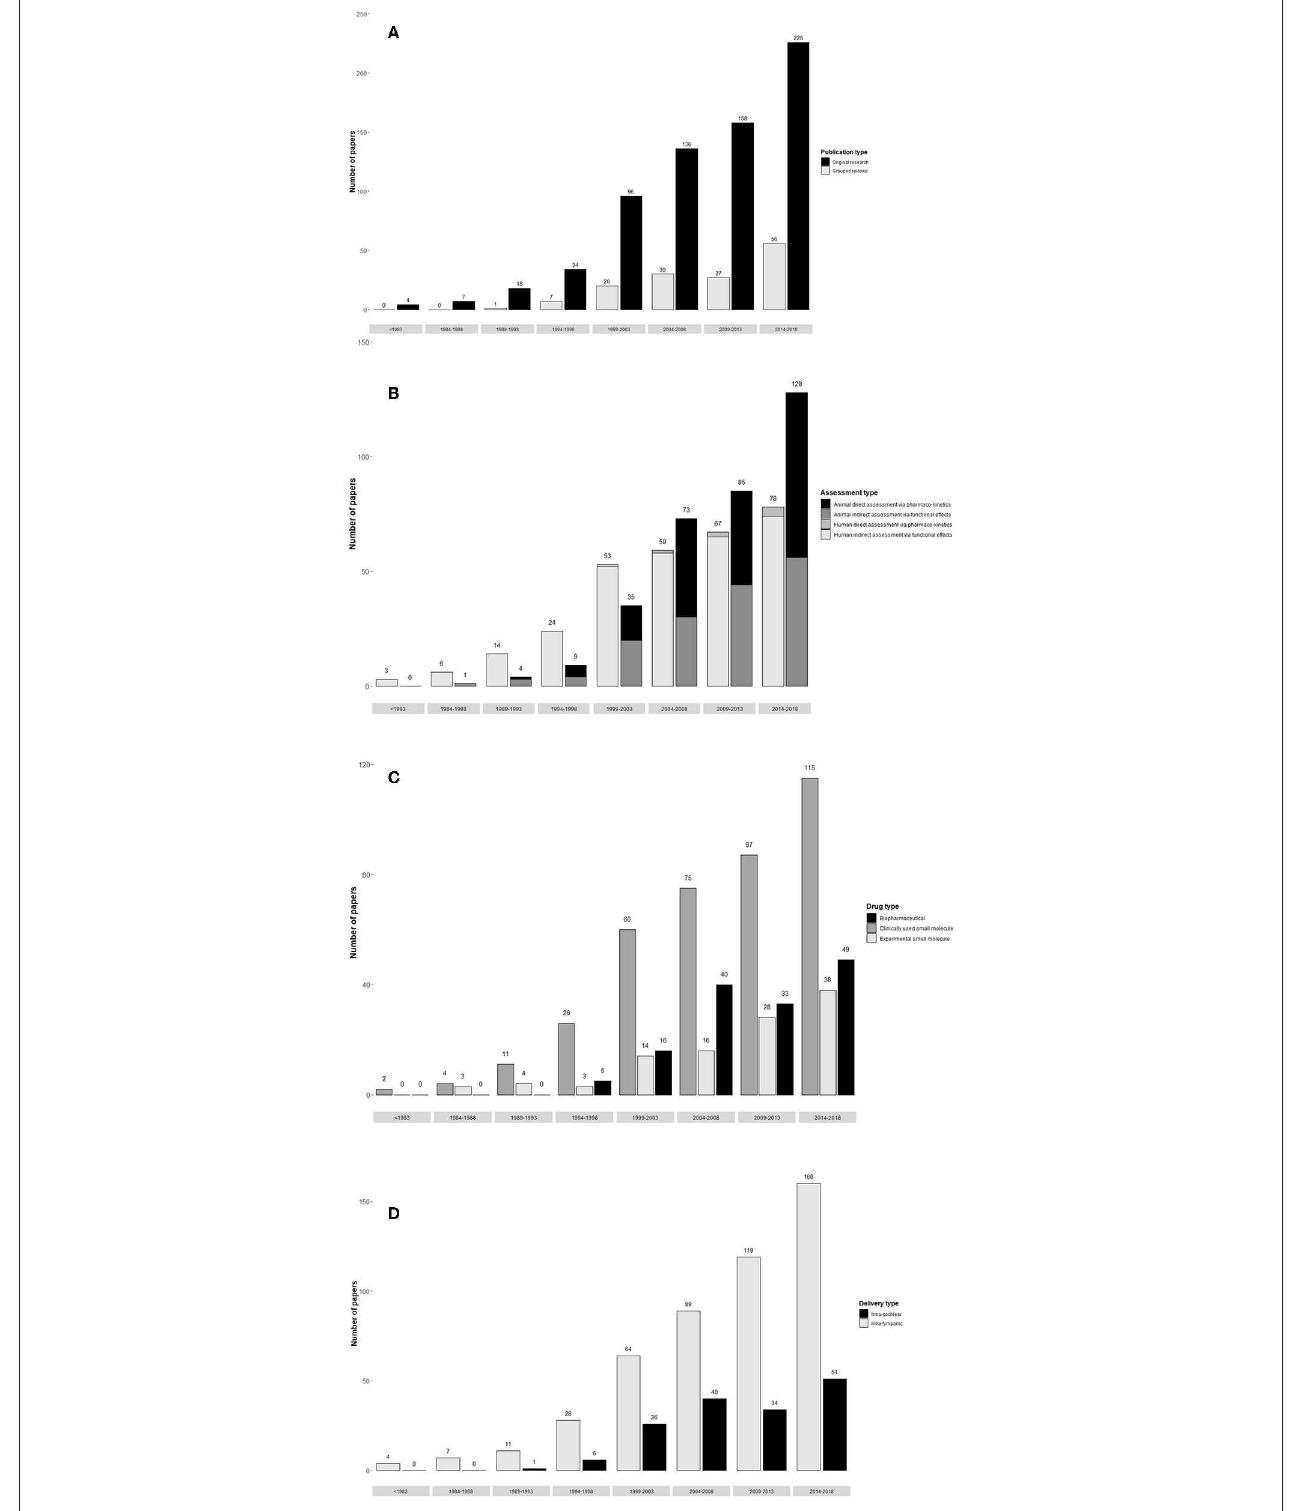
FIGURE 3 | Trends in publication of studies on local delivery to the inner ear. (A) Publications per 5 years by study type (original research or review). (B) Original research publications of per 5 years by method of assessment of delivery efficacy (direct assessment via pharmacokinetics or indirect assessment via